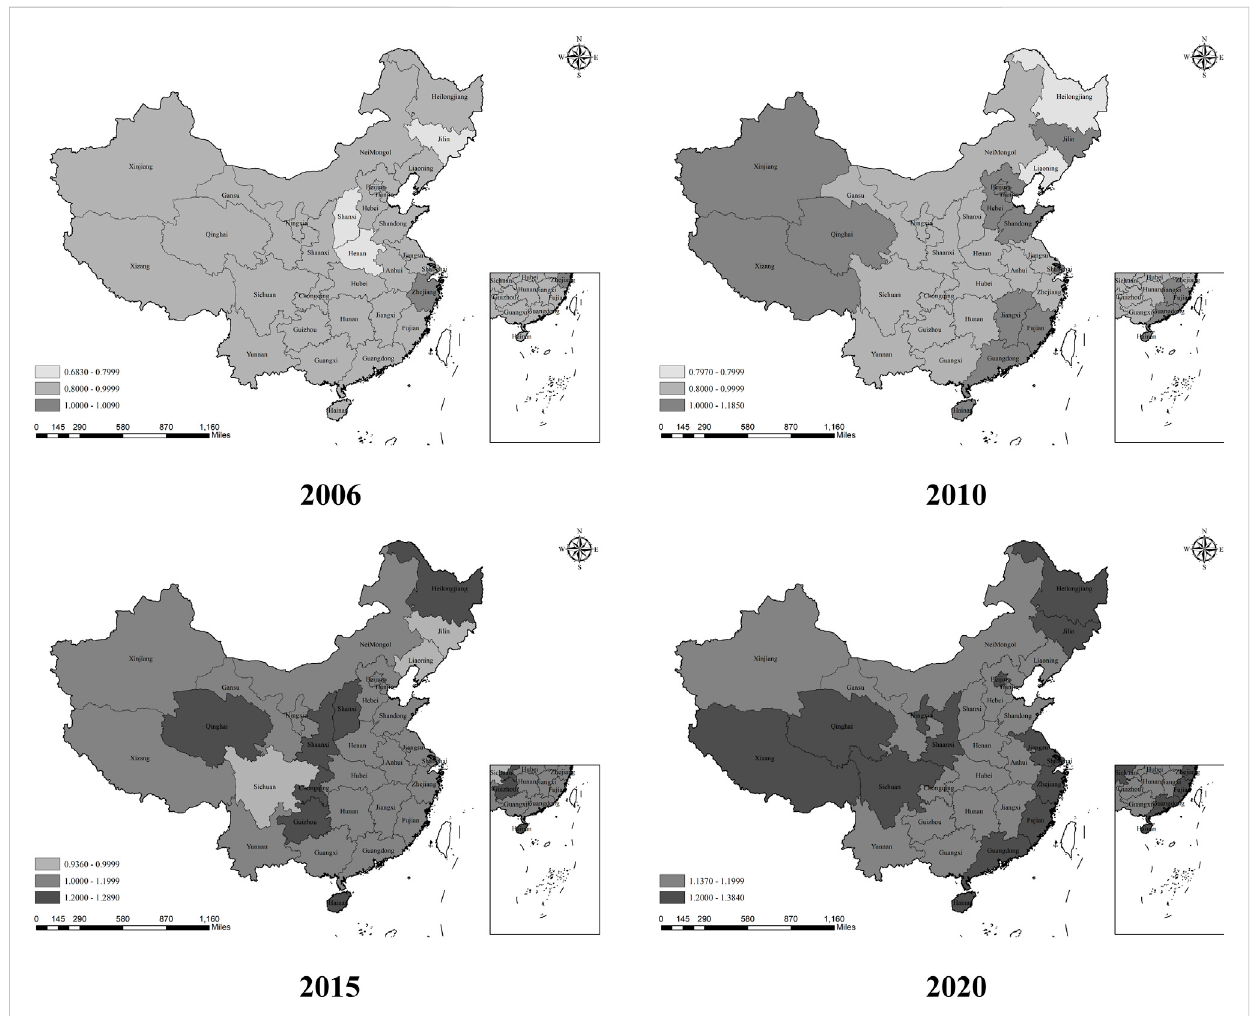
FIGURE 1 Time-space evolution trend diagram of green development quality in the construction